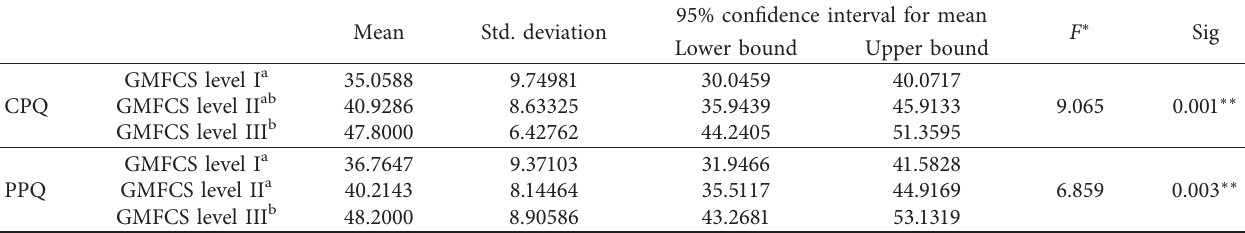
Table 3: Child and parental perception of OHRQoL according to the level of function. Mean Std.